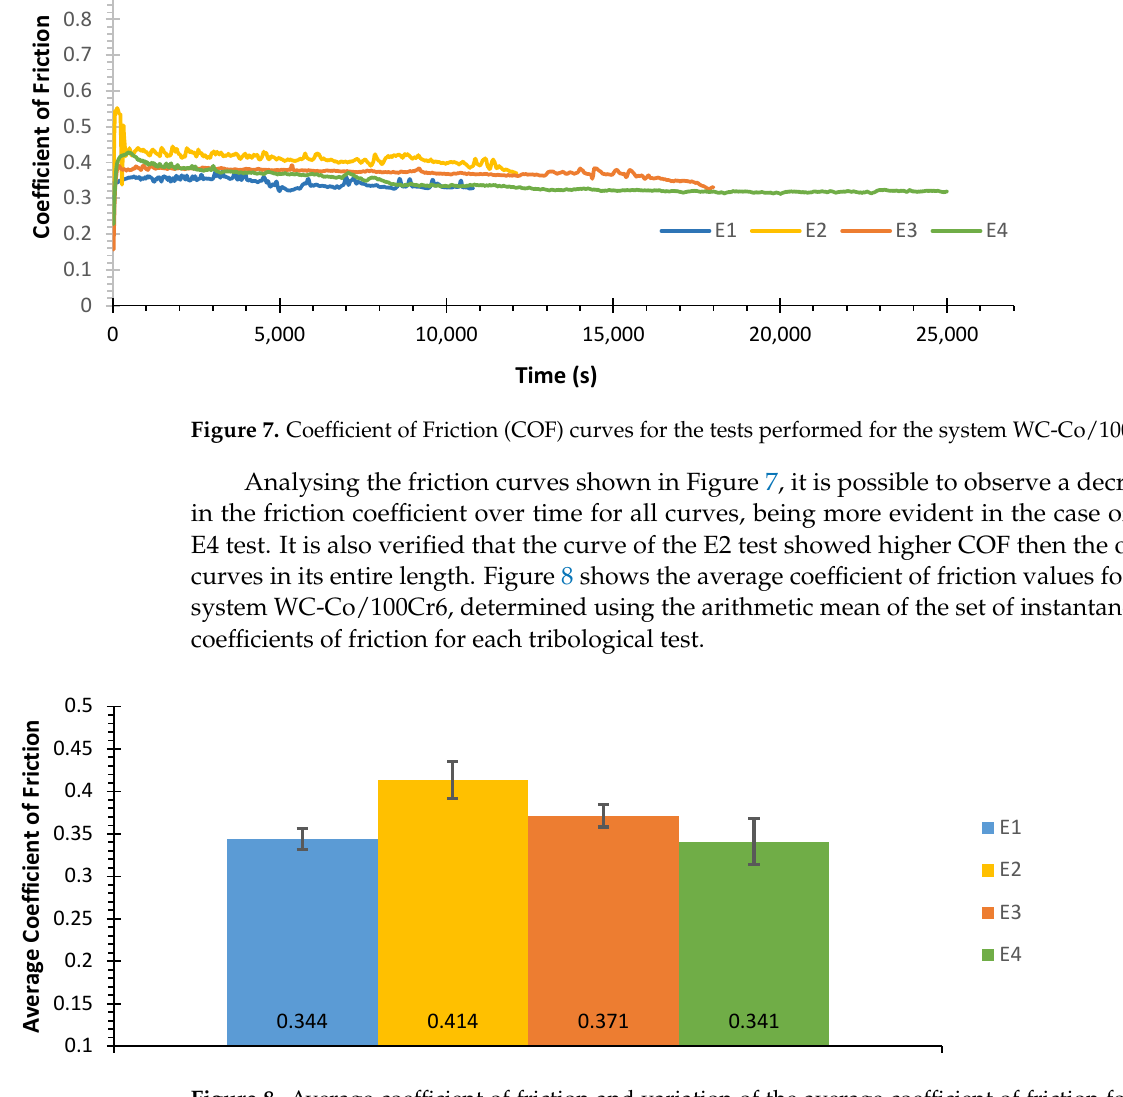
Figure 8. Average coefficient of friction and variation of the average coefficient of friction for the system WC-Co/100Cr6.